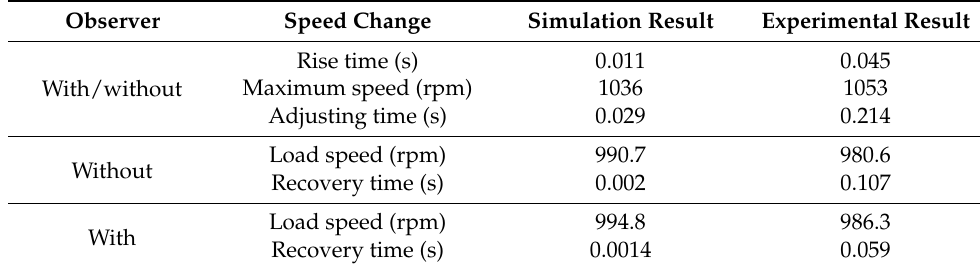
Table 4. Comparison of the simulation and experimental results with and without an observer.